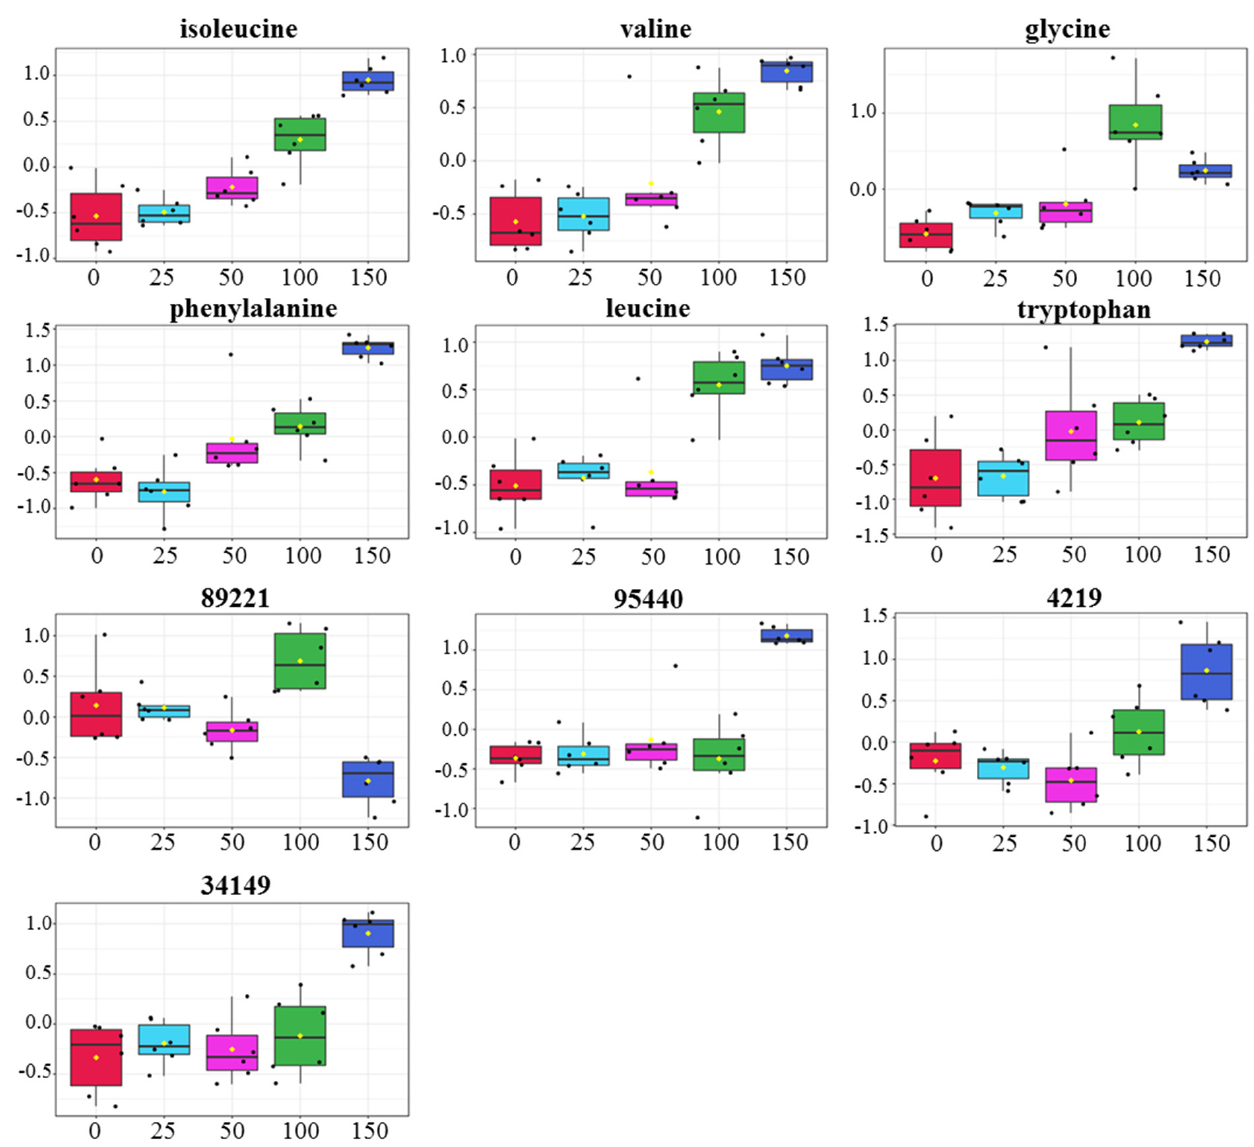
Figure 4. Metabolites that differed in gac samples due to salinity. One − way ANOVA analysis of significant metabolites measured by GC − MS − TOF in gac leaf grown under 0, 25, 50, 100, and 150 mM NaCl. Each metabolite (represented by a black dot) was individually plotted at the adjusted p − value = 0.05, post hoc analysis: Fisher’s LSD.